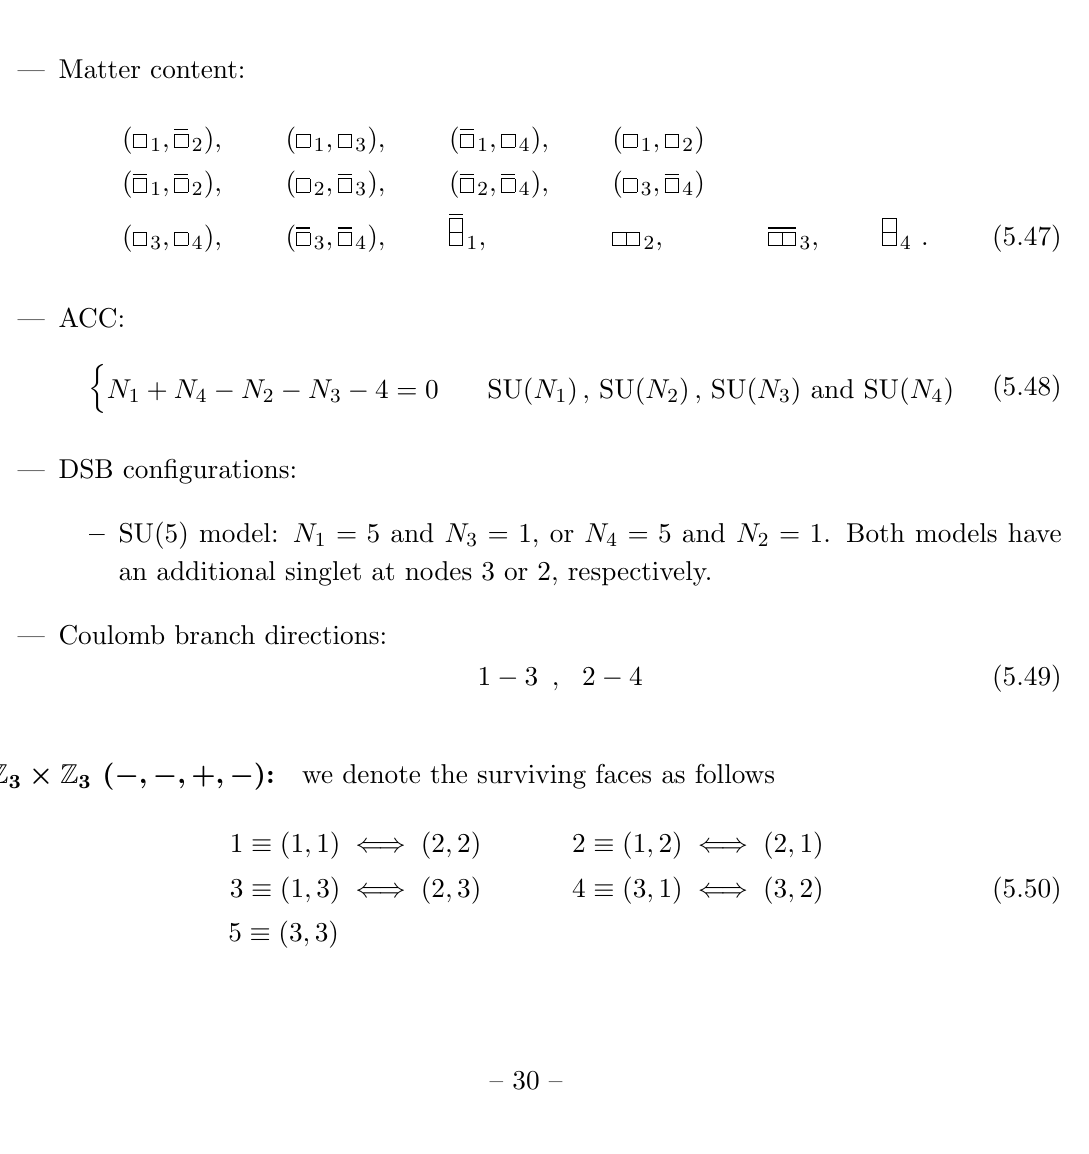
(cid:2) Z dimer with orientifold 2 4